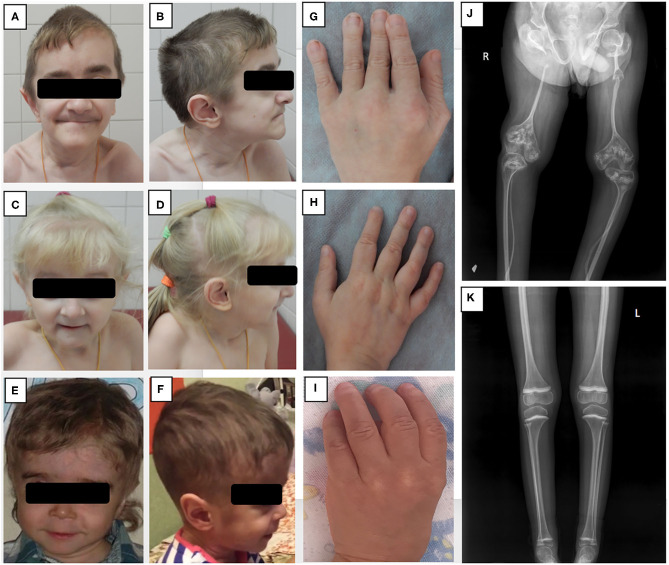
Phenotypic features and bone radiographs of three patients with NBAS mutations. (A–F) Frontal and side views of facial appearance of Patients 1, 2, and 3 at ages 13, 6, and 5, respectively. Note short neck and similar facial dysmorphism, including senile face, bilateral exophthalmos, low-set ears, narrow forehead, pointed chin, and small mouth with thin lips. (G–I) Brachydactyly and small hands of Patients 1, 2, and 3. (J, K) (J) X-ray of lower extremities of Patient 1 showing severe osteoporosis, gracile bones, signs of multiple fractures with non-union, and “popcorn” epiphyses; (K) X-ray of Patient 2 demonstrating mild osteoporosis with no axial deformities.